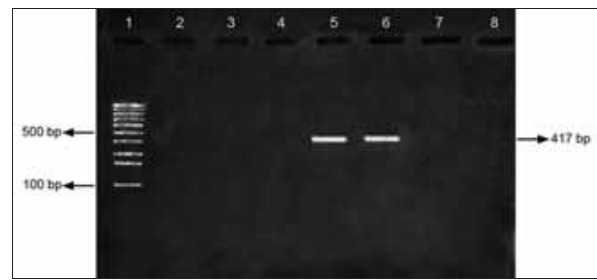
Figure-1: Agar gel elecrophoresis of polymerase chain reaction products with amplified tetA gene. Lane 1: 100 bp DNA marker; Lane 5 and 6 showing amplicons of 417 bp and samples in other lanes are